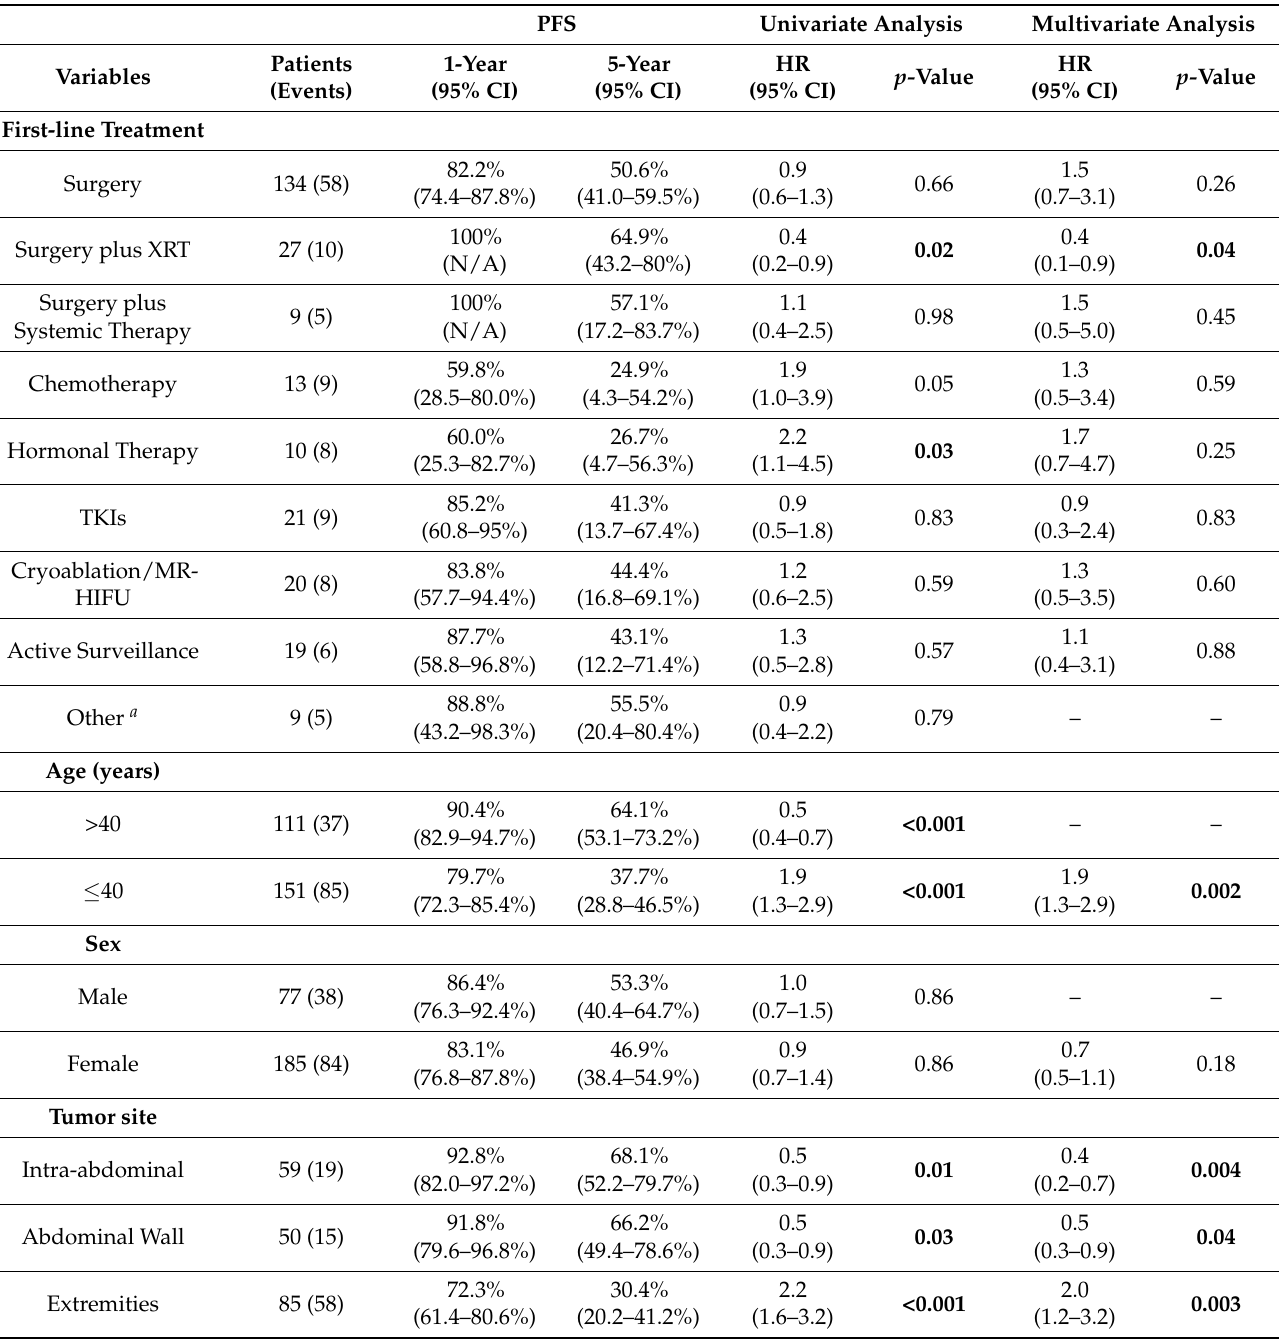
Table 2. Progression-free survival after first-line